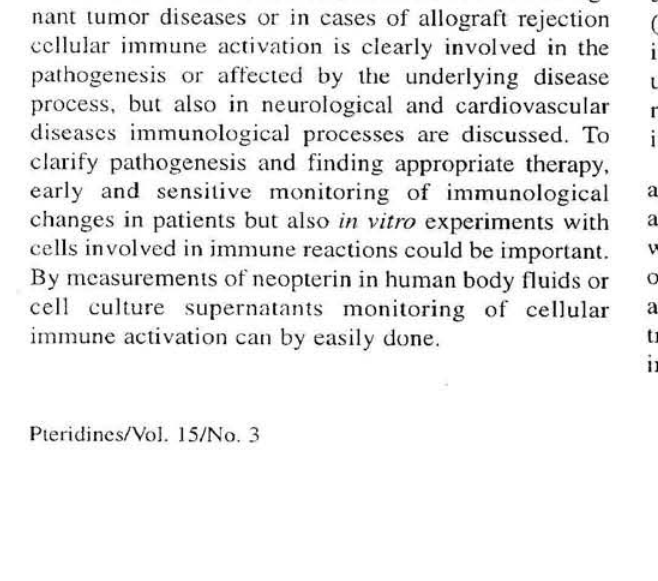
Pteridines/VoL 15/No.